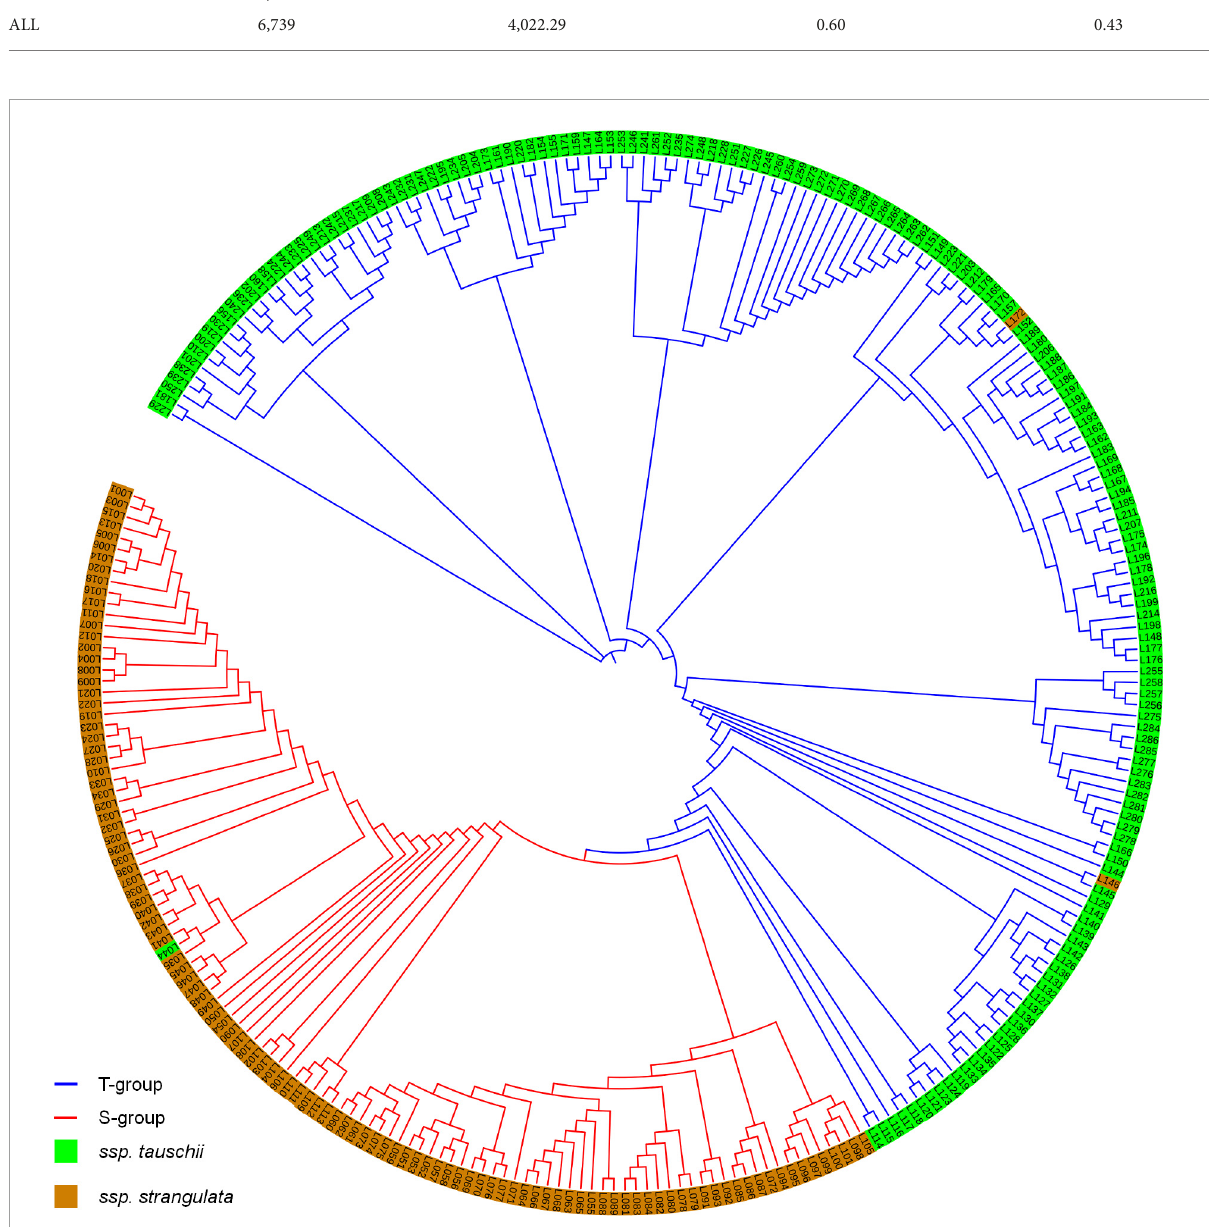
FIGURE1 Population structures of 286 Aegilops tauschii revealed by STRUCTURE 2.3.4 and neighbor-joining